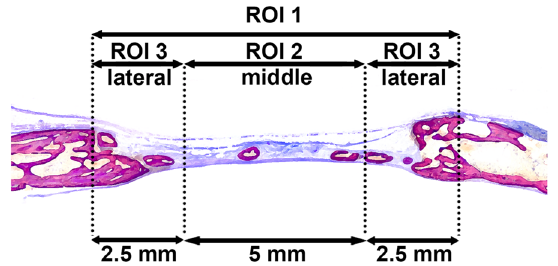
Figure 3. ROIs for histomorphometry. ROI 1 represents the whole defect area (10 mm), ROI 2 is middle area of the defect (5 mm), and ROI 3 is lateral area of the defect (2.5 mm + 2.5 mm).